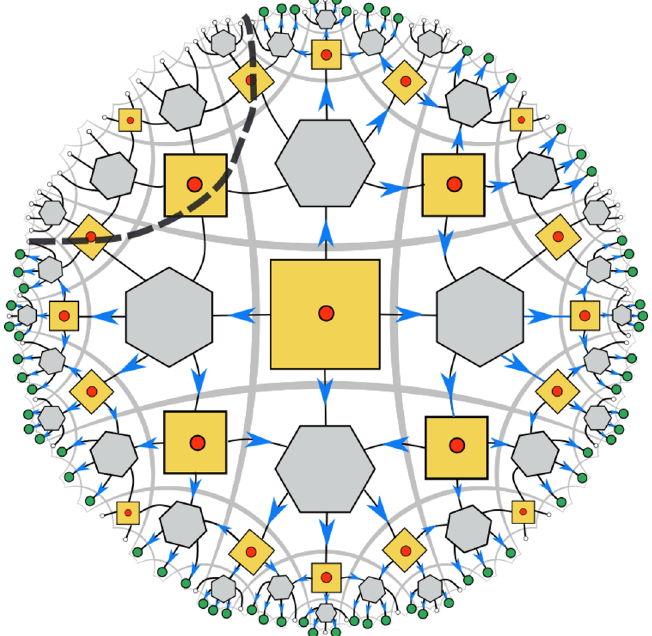
Figure 22. A weight-4 operator can be pushed to the boundary. It need not act non-trivially on the logical